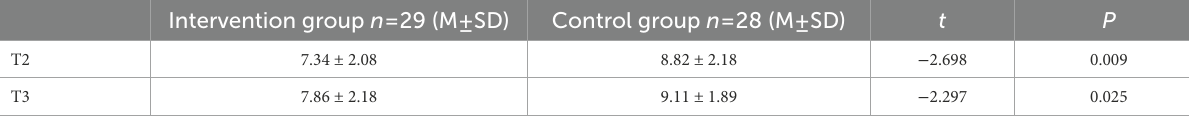
TABLE 5 Comparison of depression score among the intervention group and control group after MPST.